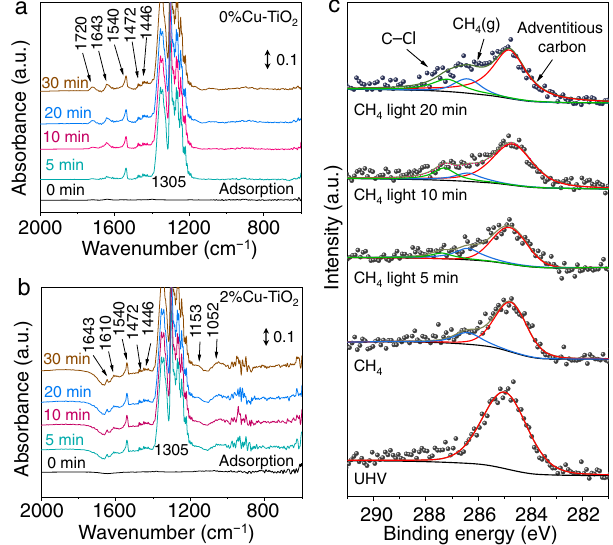
Fig. 3 | In situ characterization of photocatalytic CH 4 halogenation. a , b In situ DRIFTS spectra for photocatalytic methane halogenation over 0%Cu – TiO 2 ( a ) and 2%Cu – TiO 2 ( b ) using NaCl as halogenation agent under dark condition. c The C 1 s region of AP-XPS spectra for 2%Cu – TiO 2 under different